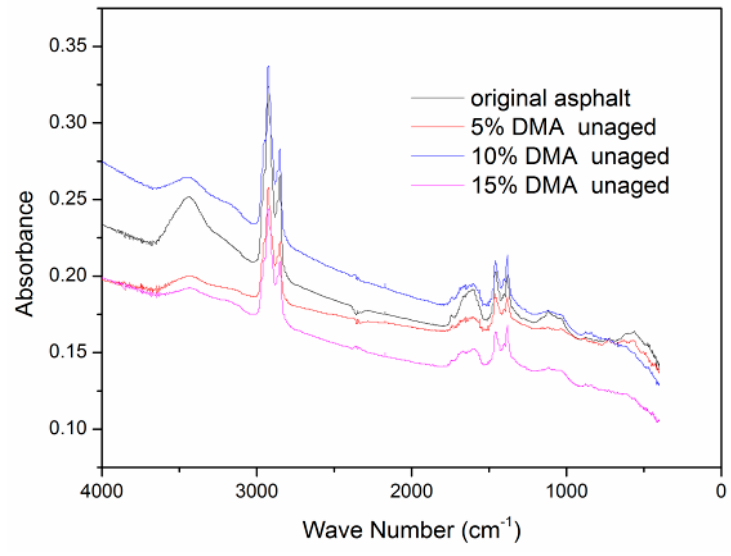
Figure 4. Spectra of neat asphalt and diatomite-modified asphalt (DMA).